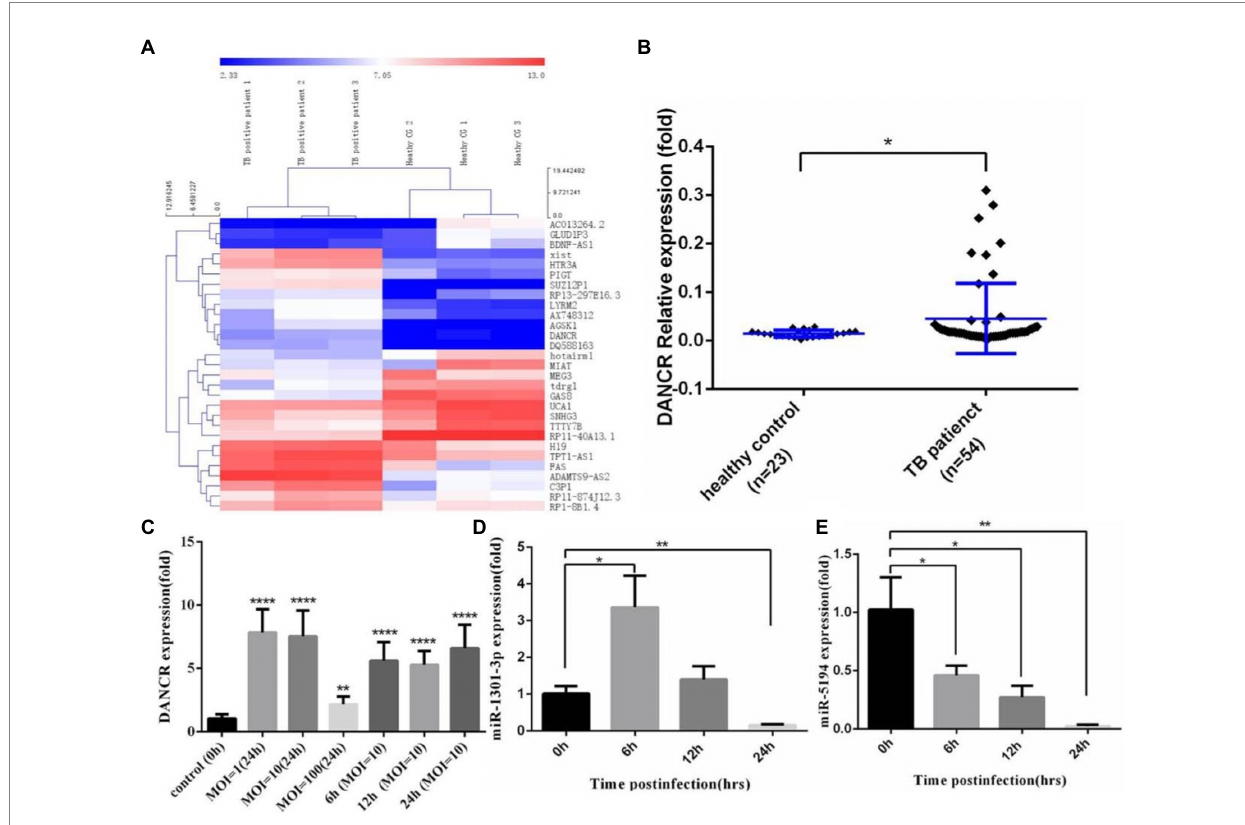
FIGURE 1 DANCR expressed abnormally in tuberculosis patients and H37Ra-infected cells. (A) Differential expression of lncRNAs in tuberculosis patients was acquired from the Gene Expression Omnibus (GEO) database with GEO2R comparison (fold change ≥ 2.0, p value ≤ 0.05) and visualized via cluster analysis. (B) The peripheral blood mononuclear cells (PBMCs) from tuberculosis patients and healthy donors were isolated, and the level of DANCR was detected by real-time reverse transcript polymerase chain reaction (qRT-PCR). (C) The monocyte cell line, THP-1 cells were stimulated with PMA before infecting with H37Ra at the MOI of 1, 10, and 100 for 24 h. To explore the variation trend of DANCR, the cells were infected with H37Ra at the MOI of 10 and harvested at indicated time post-infection. The expression of DANCR was determined by qRT-PCR. (D,E) THP-1 cells were treated with PMA for 24 h and infected with H37Ra at 10 times MOI. The expression levels of miR-1301-3p (D) and miR-5194 (E) at different times post-infection were measured by qRT-PCR. Data represent the mean ± standard deviation (SD) from three replications. A two-tailed Student’s t -test was used for statistical analysis. * p < 0.05, ** p < 0.01, and **** p <